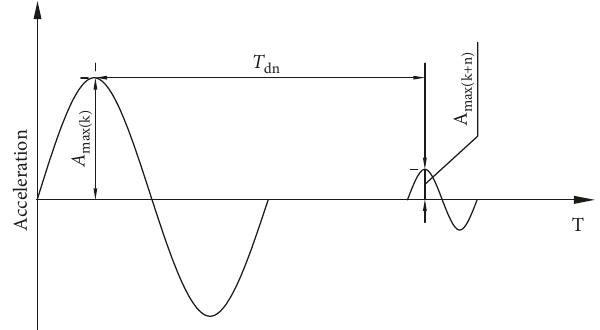
Figure 19: Curve of amplitude oscillatory. T between maximum amplitude in k th period and maximum am- plitude in ( k + n ) th period.